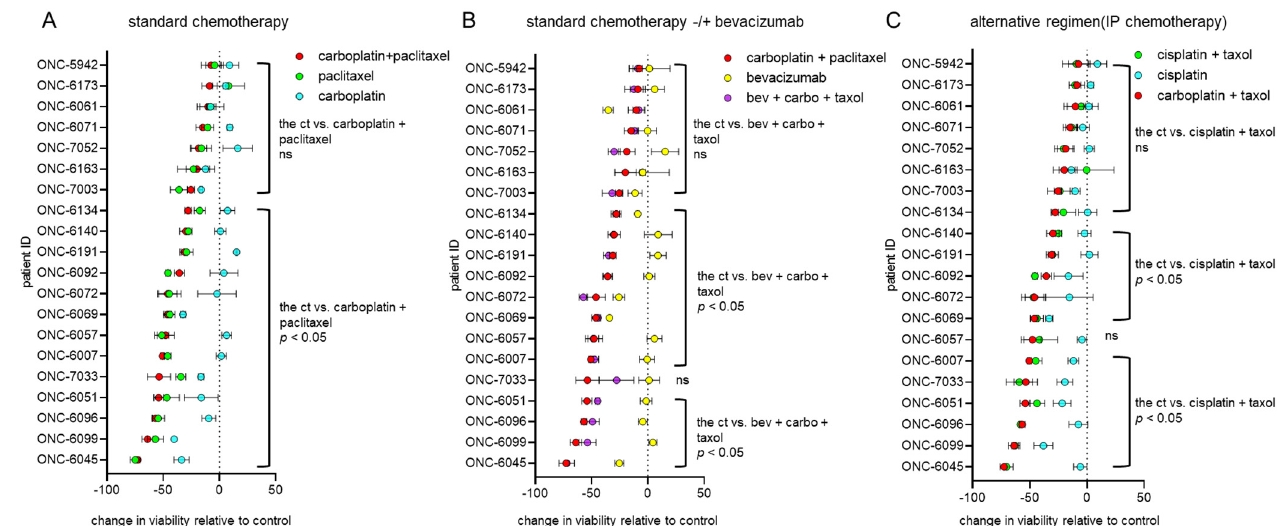
Figure 1. Therapeutic efficacy of the first-line therapies for endometrial and ovarian cancers using PDO models. Endometrial and ovarian cancer PDO response to ( A ) the standard chemotherapy, ( B ) the standard chemotherapy ± bevacizumab and ( C ) the most common alternative chemotherapy regimen. PDO models were treated with the indicated agents for 72 h, followed by assessment of cell viability. The data were calculated as the change in viability relative to the control which was set at 100% (i.e., no cell death). The samples are ordered based on increasing sensitivity to carboplatin + paclitaxel (red circles). Statistical significance was assessed by two-way ANOVA with the Greenhouse–Geisser correction and Tukey’s multiple comparison test. Significant differences vs. the control are annotated on each panel. All the statistical comparisons are provided in Supplementary Table S2, including specific p -values and comparisons of single agents vs. control or dual treatments.